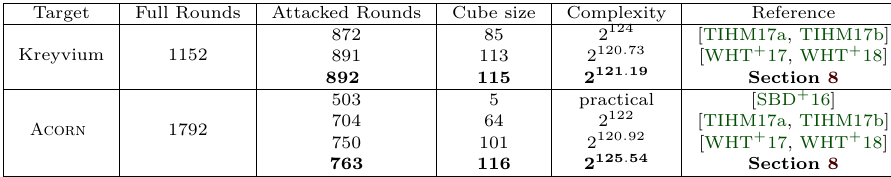
Table 2: Cube Attacks on Kreyvium and